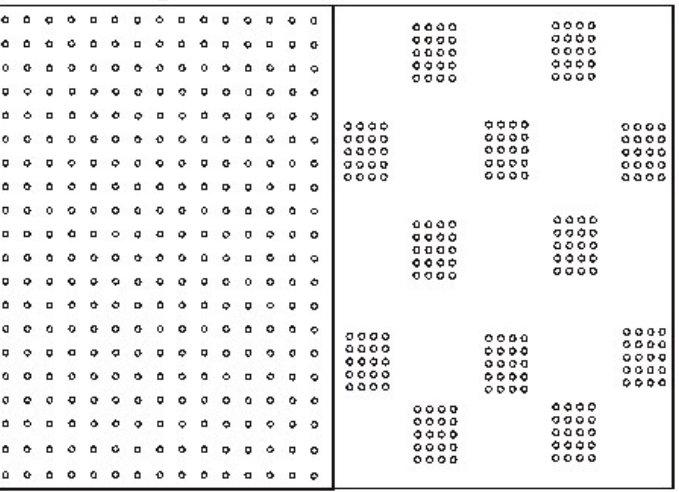
Figure 7. Manual transplantations: ( a ) temporary storage of sods on boat, ( b , c ) transfer and deposition of the sods in the transplantation site and ( d ) sods protected with 10 cm mesh metal nets.